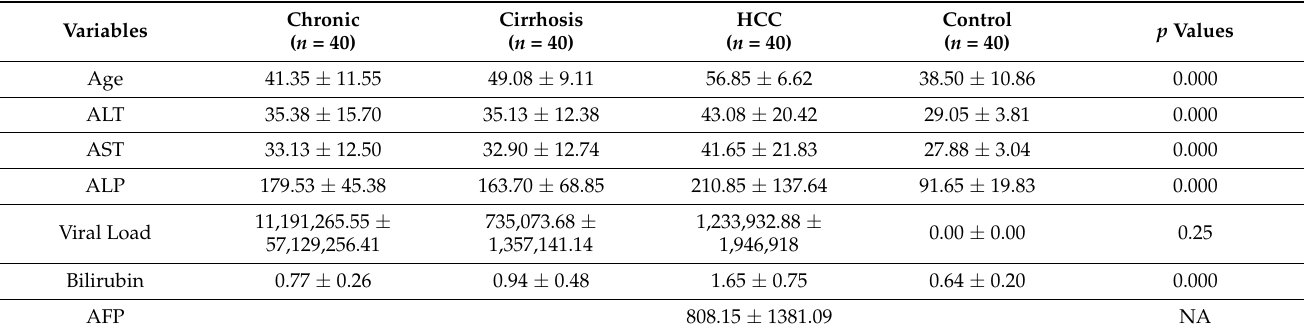
Table 4. Analysis of variance of age and biochemical parameters in the chronic, cirrhosis, HCC, treated, and control